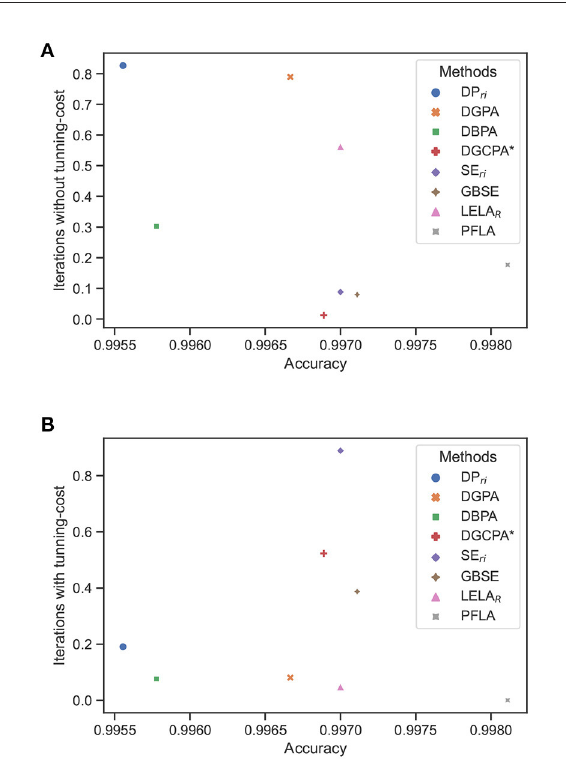
FIGURE4 Averaged iterations vs. averaged accuracy in the nine benchmark environments of compared methods. (A) Without considering the parameter tunning cost. (B) With consideration of the parameter tunning